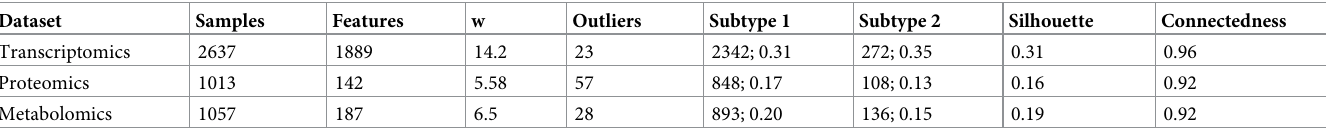
Table 2. Final subtyping results based on AE and MineClus for each -omics data. For each -omics type the total number of samples and features, two subtypes (size; sil- houette), and number of outliers is listed along with the overall silhouette and connectedness.